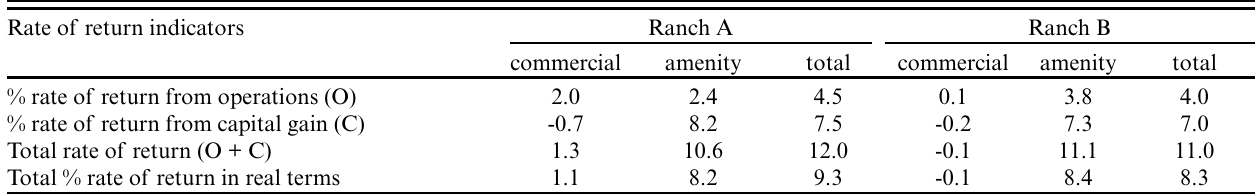
Table 2. Rates of return from commercial versus amenity income from two ranch case studies in California Mediterranean rangelands. Rate of return